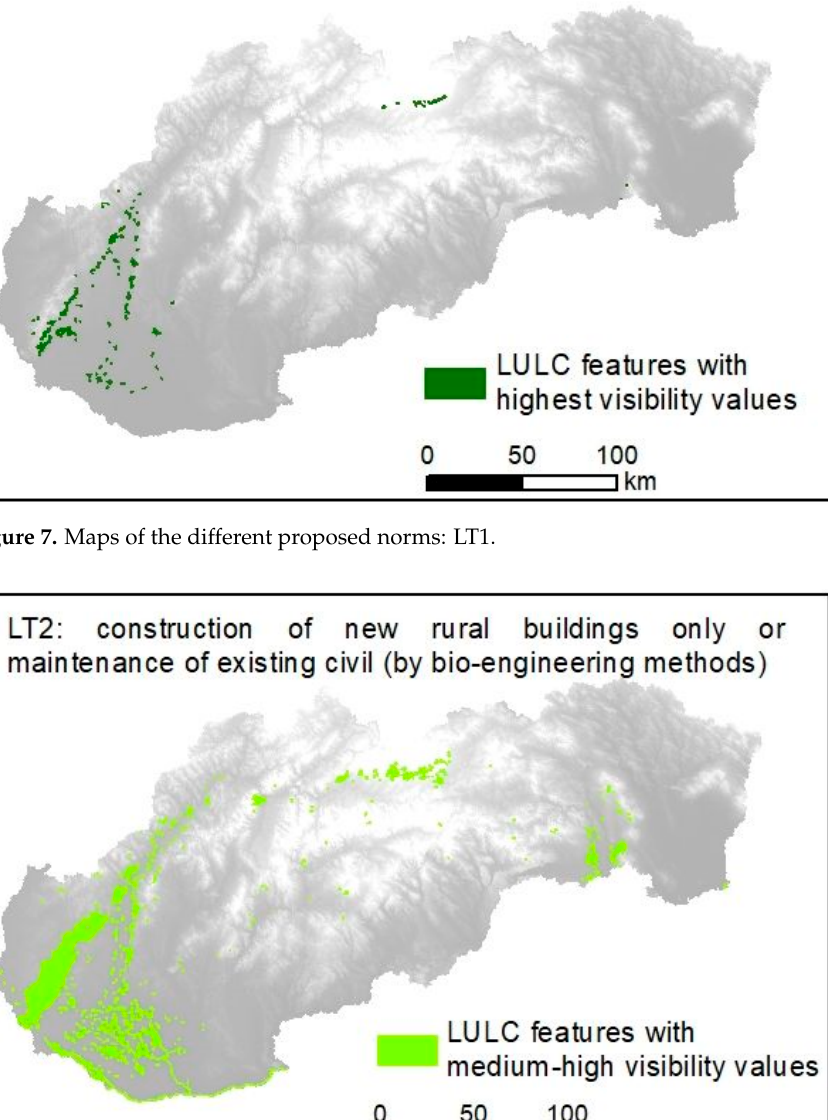
Figure 8. Maps of the different proposed norms: LT2.